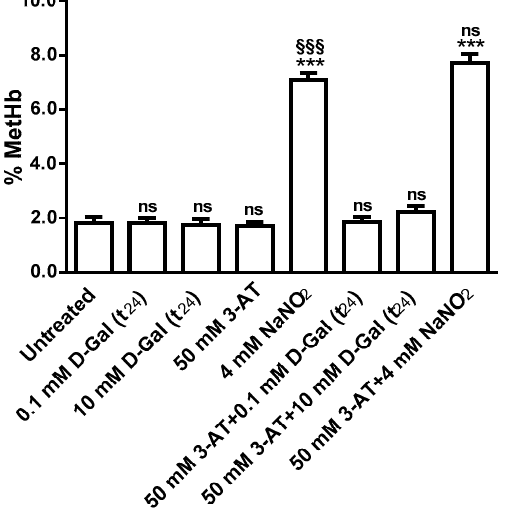
Figure 5. MetHb levels (%) in untreated (control) and in 0.1 or 10 mM D -Gal(t 24 )-treated erythrocytes with or without 50 mM 3-AT. ns, not significant versus untreated erythrocytes (control) and 4